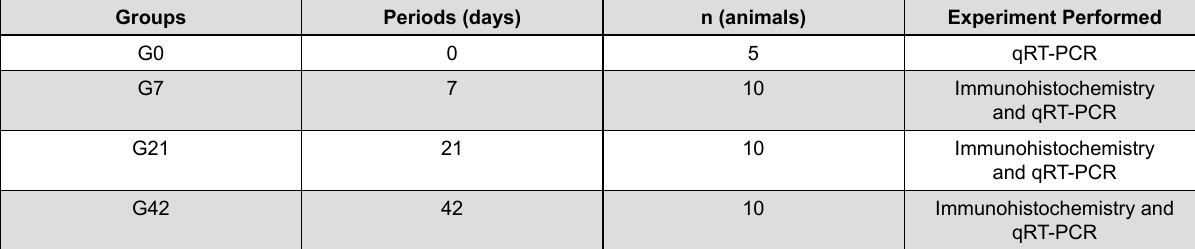
Figure 1- Description of animal